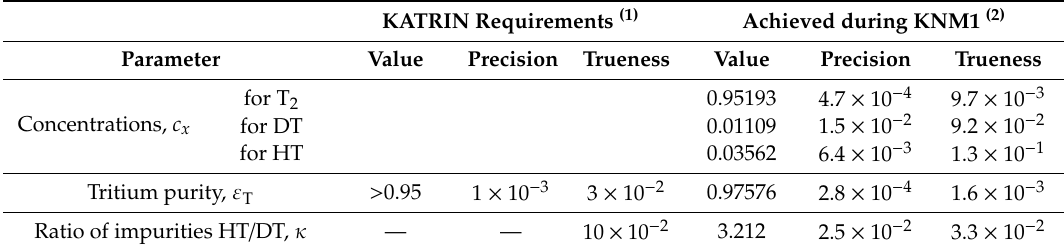
Table 5. Typical monitoring parameters for the gas composition in KATRIN: comparison of the specification requirements and the values achieved during first KATRIN neutrino mass data taking. Precision and trueness are given relative to their value, | ∆ X/X |